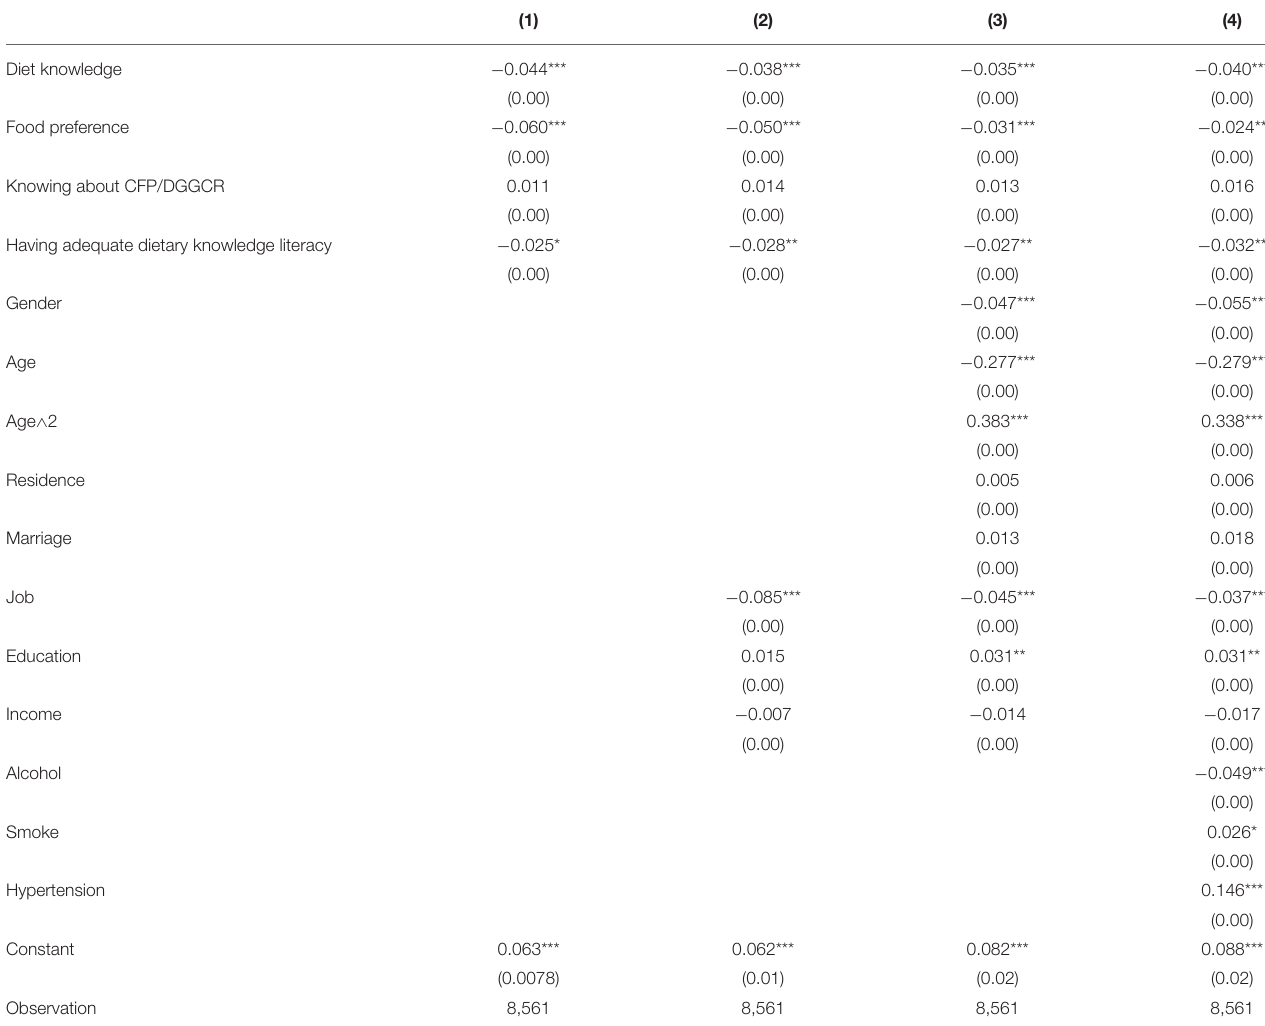
TABLE 2 | OLS estimates-effect of diet score on